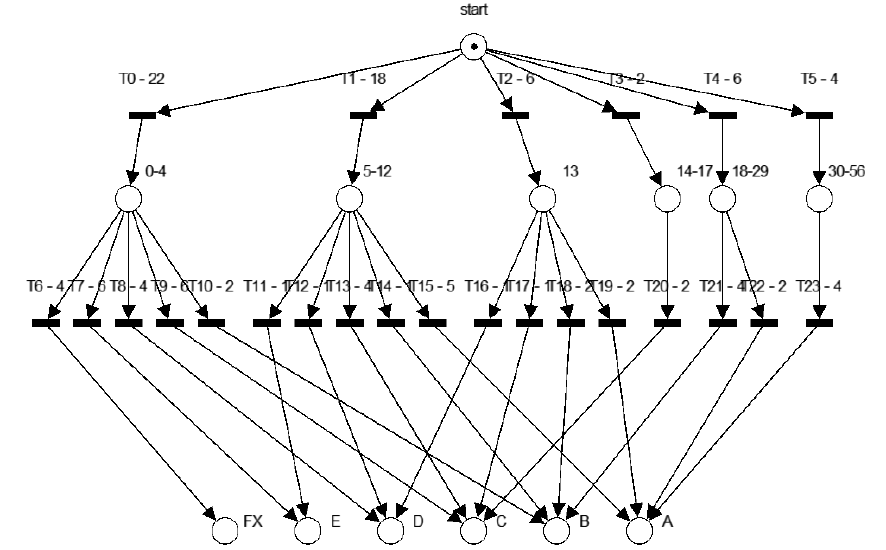
Figure 15. Model of grade probability for a single student.